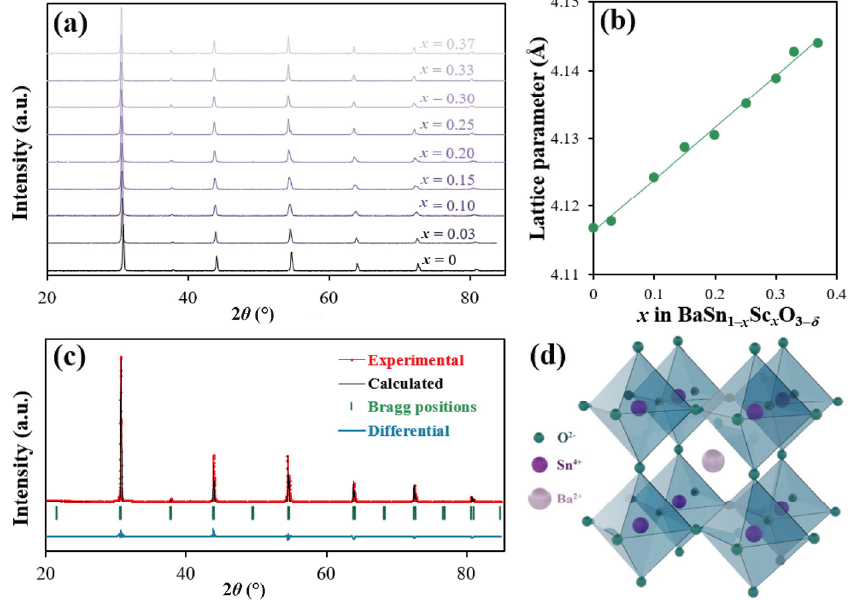
Fig. 1 Structural characterizations of BaSn 1 − x Sc x O 3 − δ compounds: (a) XRD patterns; (b) concentration dependence of lattice parameter; (c) Rietveld refinement analysis performed for undoped barium stannate; and (d) cubic-type perovskite crystal